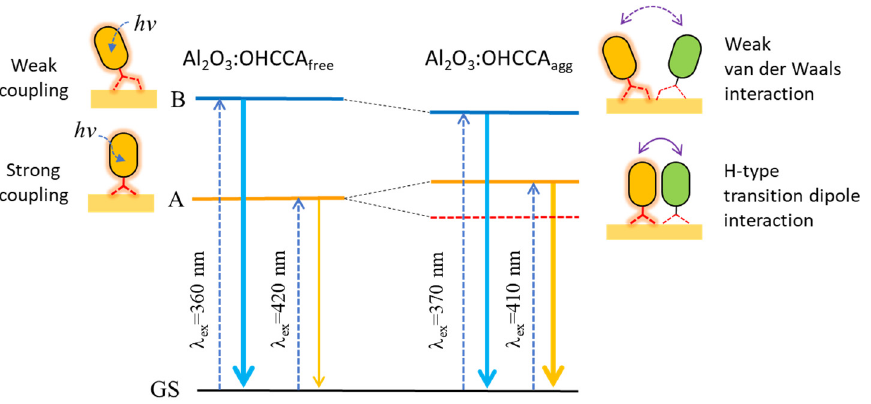
Figure 3. Schematic energy level diagrams for the electronic transitions in the film samples. A, B, and GS denote the bidentate binding state, the monodentate binding state, and the ground state, respectively (see proposed anchoring modes in Figure S4).